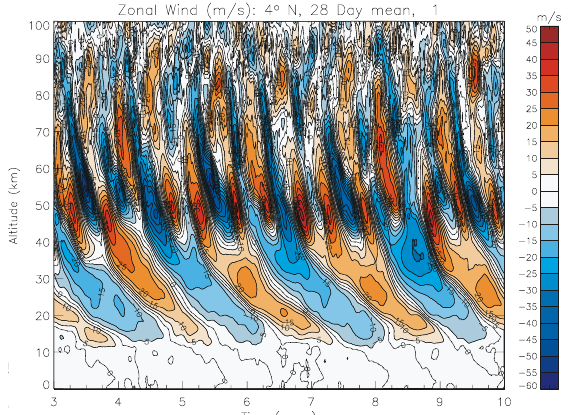
Fig. 3. Monthly average of computed zonal winds near the equator at 4 ◦ latitude (Gaussian point). With a period close to 24 months, the Quasi-biennial Oscillation (QBO) has an amplitude of almost 20m/s at 30km. Higher-up, the Semi-annual Oscillation (SAO) dominates with amplitudes exceeding